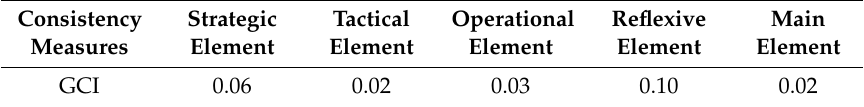
Table 9. Consistency index of collective judgement.